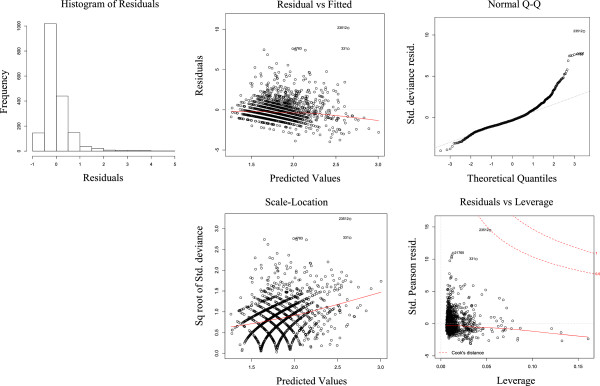
Poisson model residual plots.